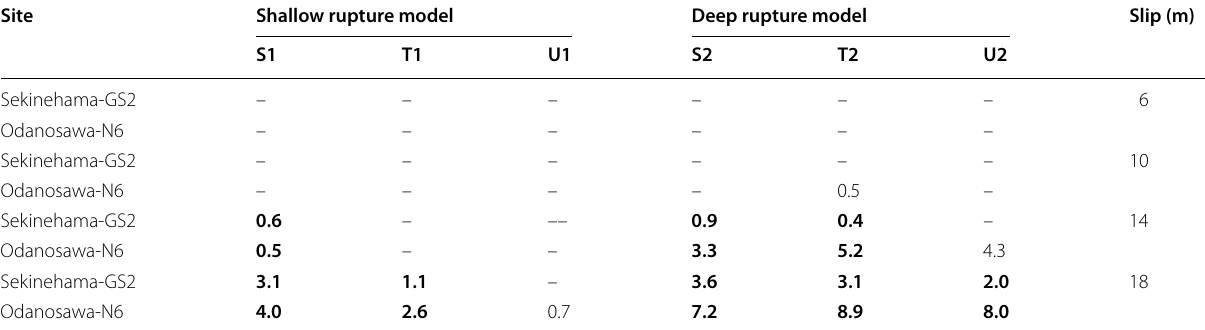
Table 6 Computed inundation depth at Sekinehama and Odanosawa using six newly proposed fault models